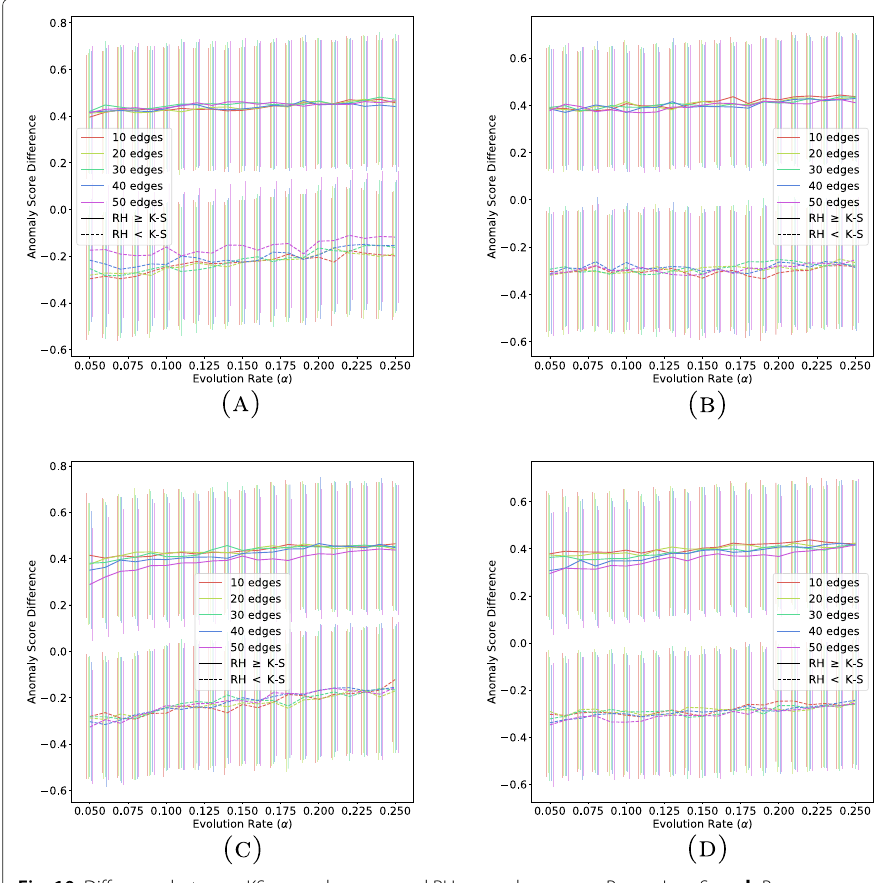
Fig. 10 Difference between KS anomaly scores and RH anomaly scores. a Power-Law Scan. b Bump Power-Law Scan. c Power-Law Lateral movement. d Bump Power-Law Lateral